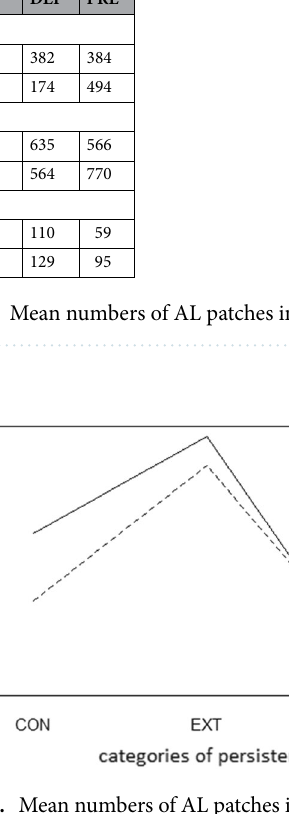
Figure 5. Mean numbers of AL patches in individual categories of persistence.